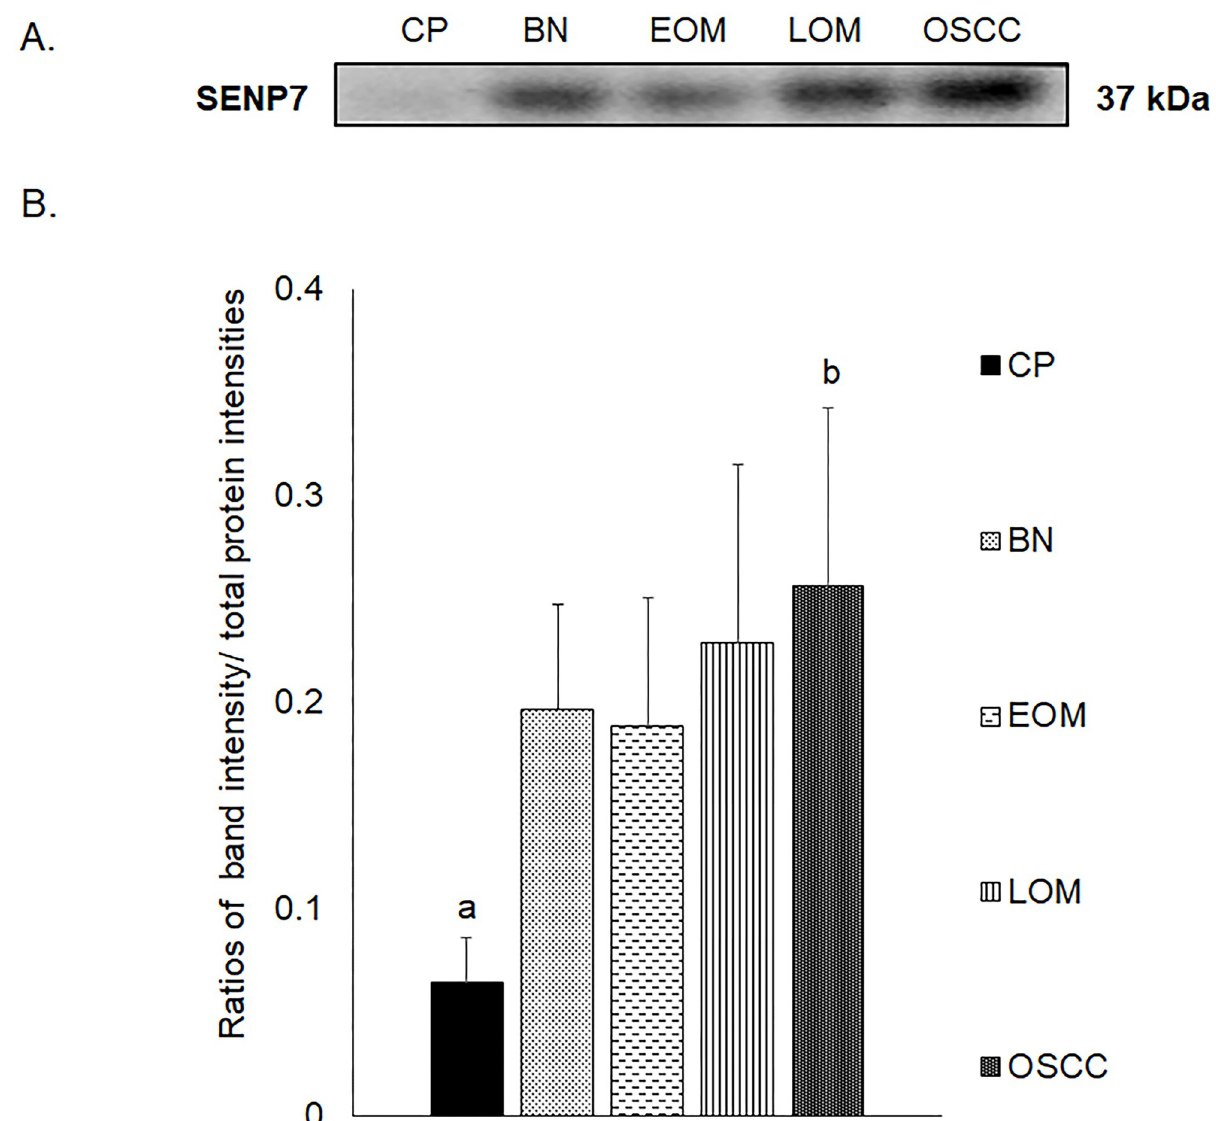
Fig 8. Western blot analysis of salivary sentrin-specific protease 7 (SENP7) of pooled saliva samples from dogs with periodontitis and normal controls (CP), benign oral tumors (BN), early- and late-stage oral melanoma (EOM and LOM, respectively) and oral squamous cell carcinoma (OSCC). Representative western blot for SENP7 at 37 kDa (A) and bar graph of ratios of SENP7 protein intensity to total blotted protein intensities in each lane in the second half of a membrane � (B) . a–b denote a significant difference at p < 0.05.